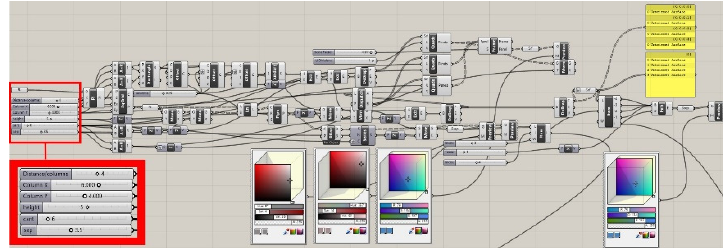
Figure 4. Grasshopper Algorithm for Parametric Modeling with Customized Sliders.